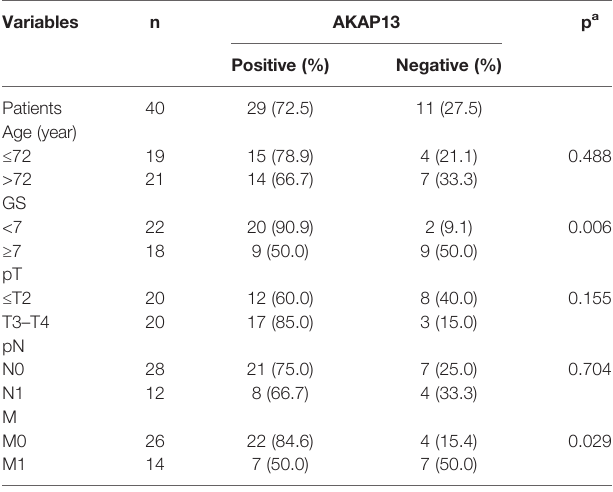
TABLE 1 | Correlation between AKAP13 expression with clinicopathological characteristics in PCa.